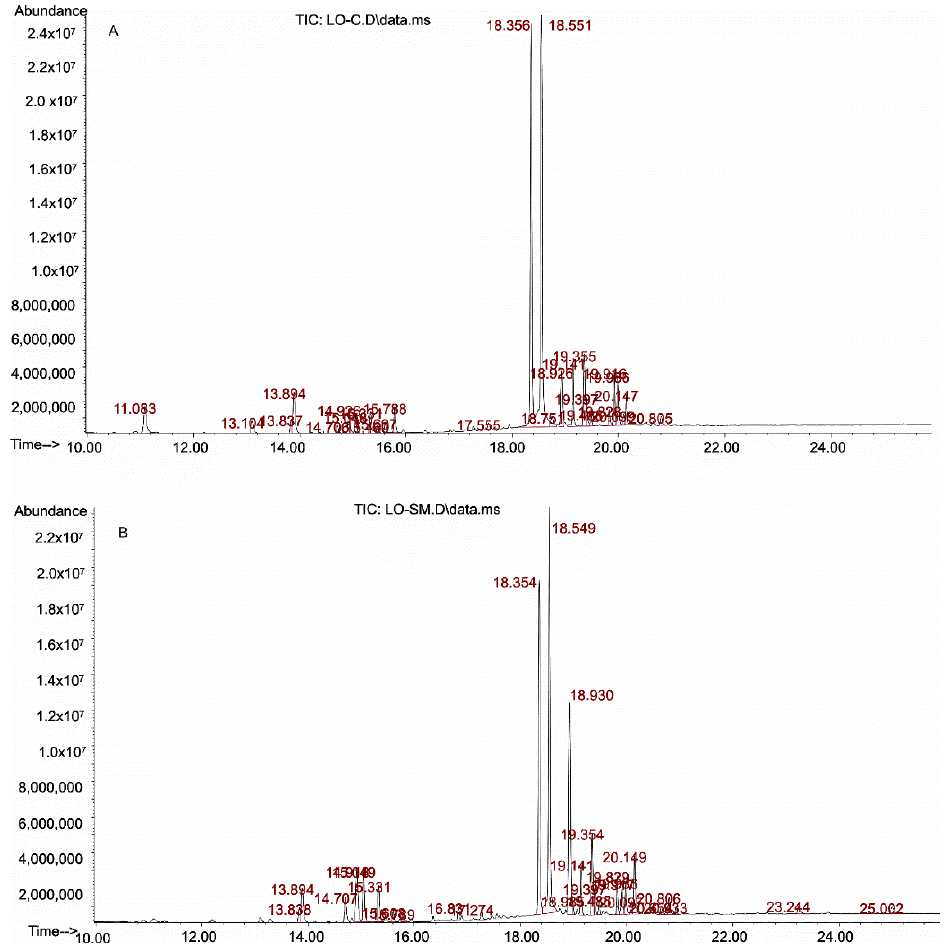
Figure 1. Chromatograms of the tested samples of lavender oils: A —commercial sample (LO-C), B —self-manufactured sample (LO-SM).